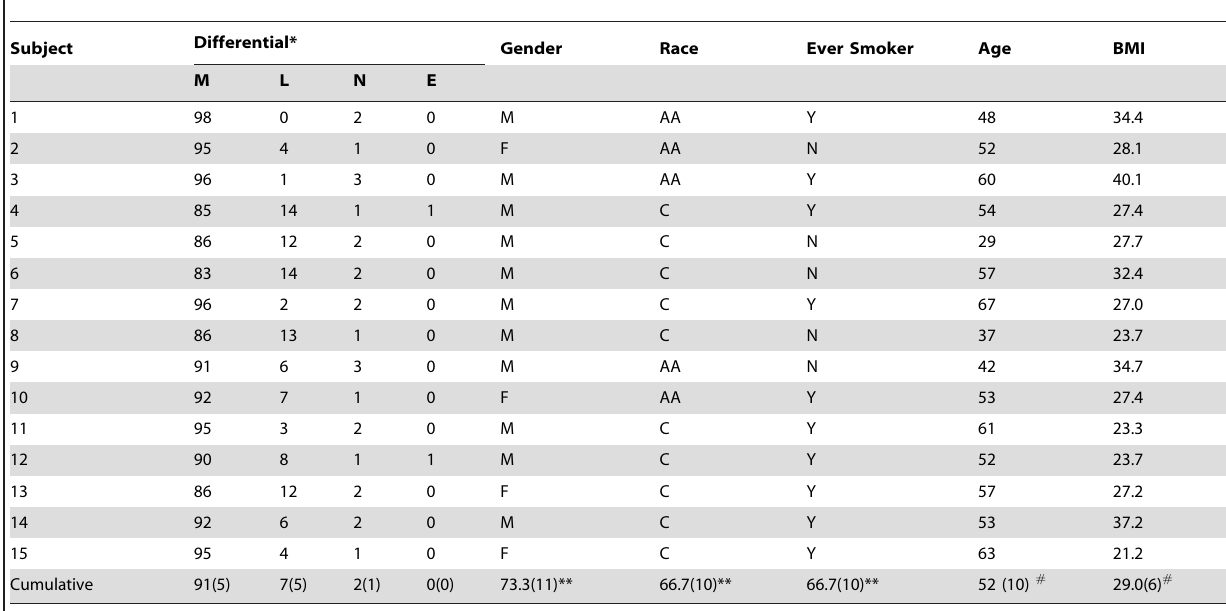
Table 1. BAL Differential and Demographics of Study